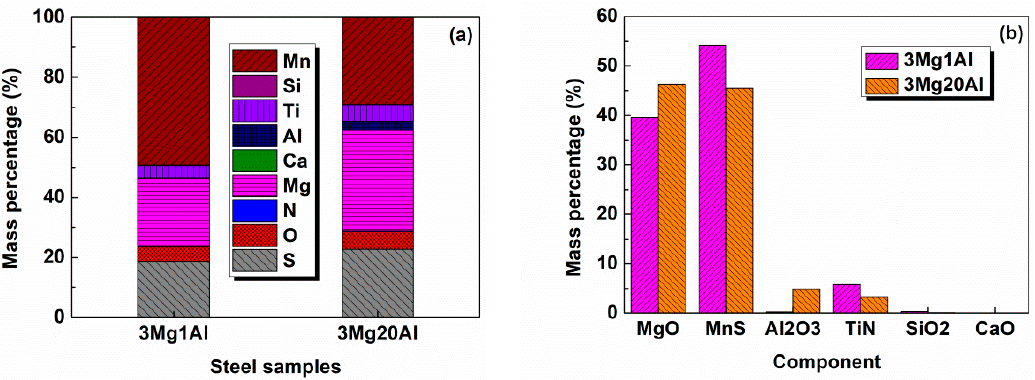
Figure 6. Comparison of the average composition of inclusions in 3Mg1Al and 3Mg20Al.